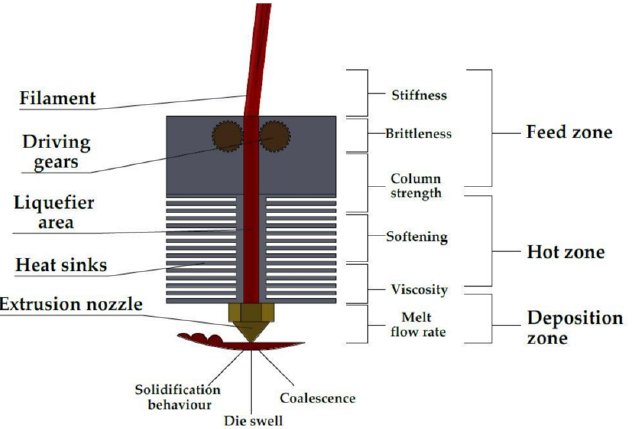
Figure 2. Scheme of the extruder in FFF applications. Image from reference